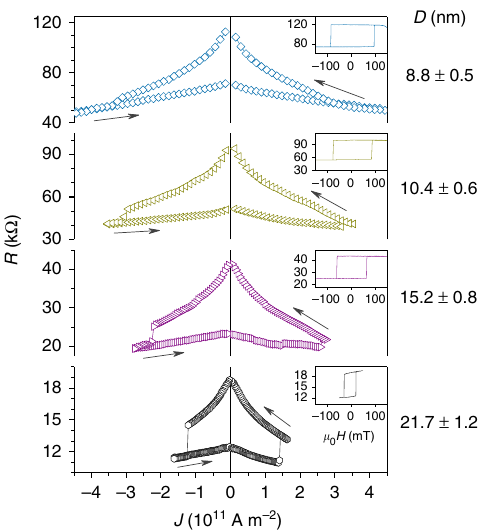
Fig. 4 Current-induced switching properties. R in response to applied current density J ( R – J curves) for MTJs with various diameters D . The insets show the R – H loop for the same